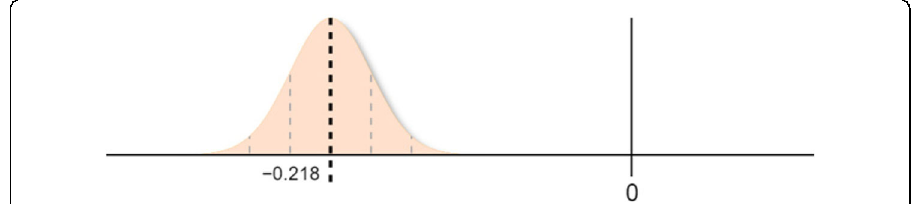
Fig. 6 Difference of means (d = − 0.218, SE = 0.0294, p <